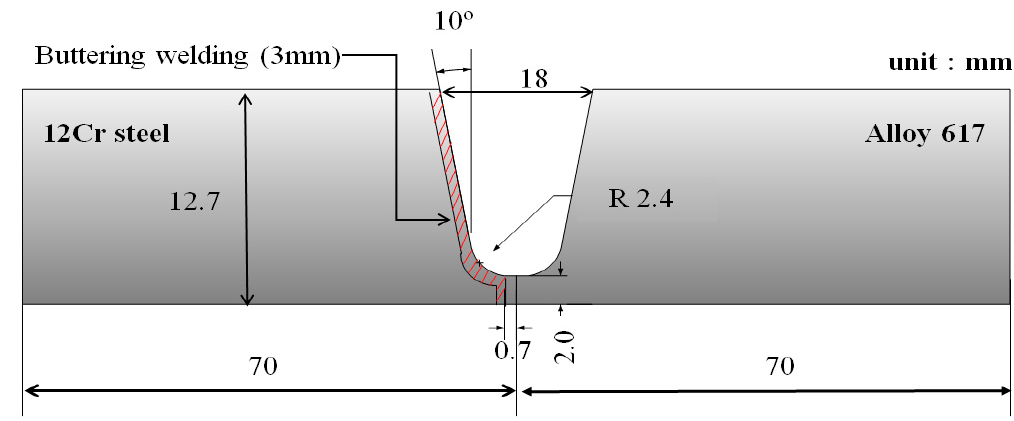
Figure 1. Design of narrow gap U-shaped groove.